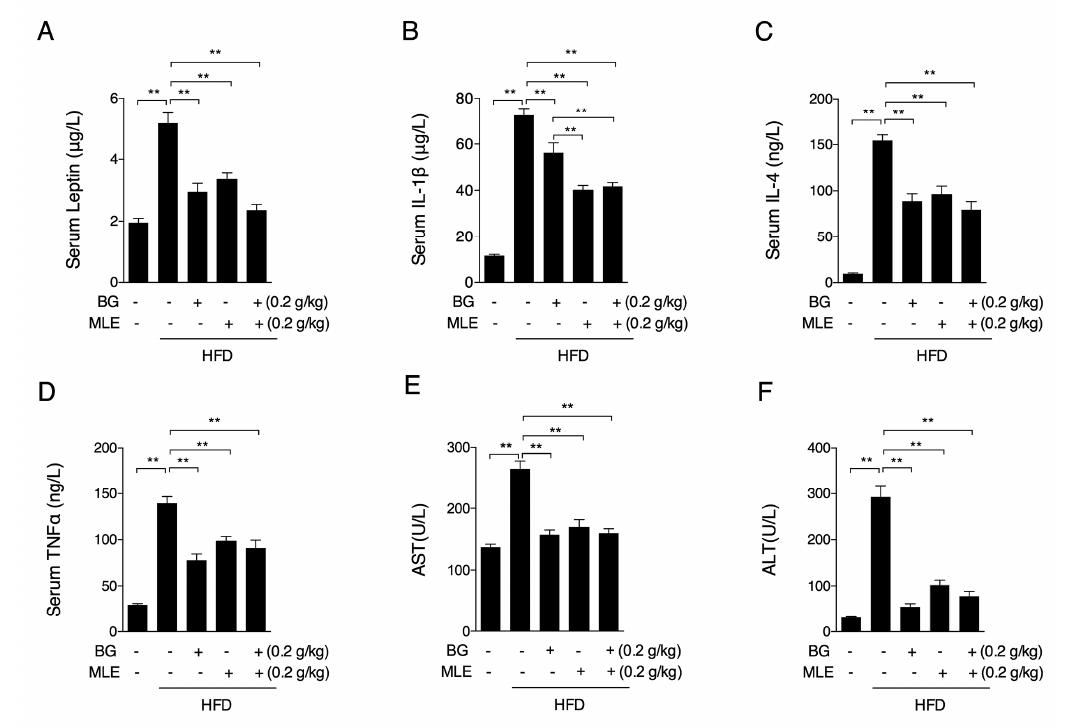
Figure 4. Effects of BG and MLE on serum cytokines. Serum leptin ( A ); IL-1 β ( B ); IL-4 ( C ); TNF α ( D ); AST ( E ) and ALT ( F ) levels in male C57BL/6 mice fed a control diet or a high-fat diet supplemented with BG or/and MLE for 12 weeks. The data are the mean ± SEM, n = 10. * p < 0.05, ** p < 0.01 vs. related control.